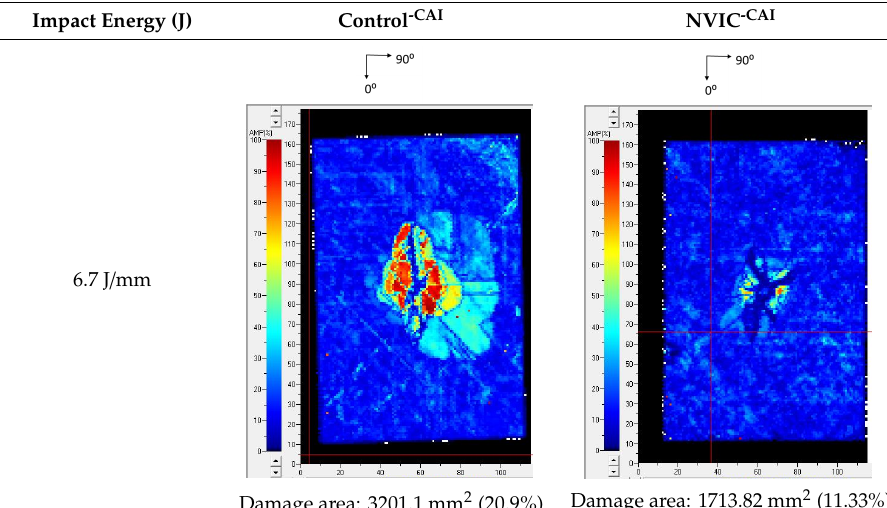
Figure 15. Time histories of the applied force during impact test. Table 7. Characteristics of impact damage area.